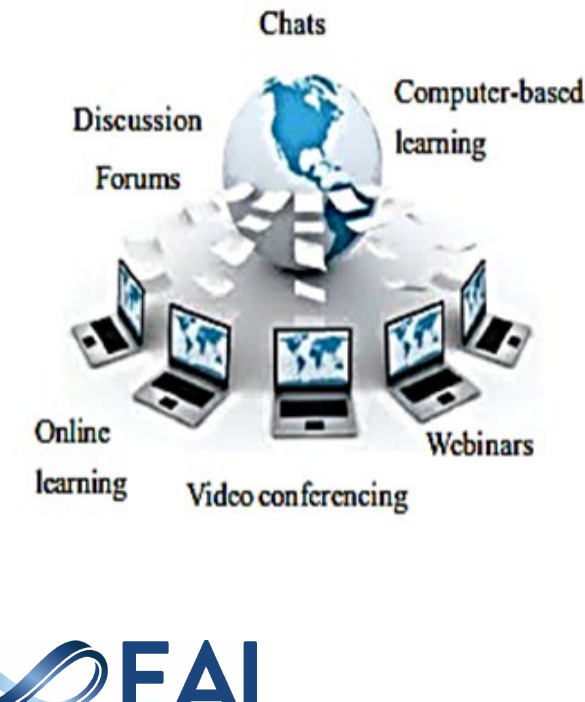
Figure 2. Electronic interactivity in a collaborative digital learning environment [62]